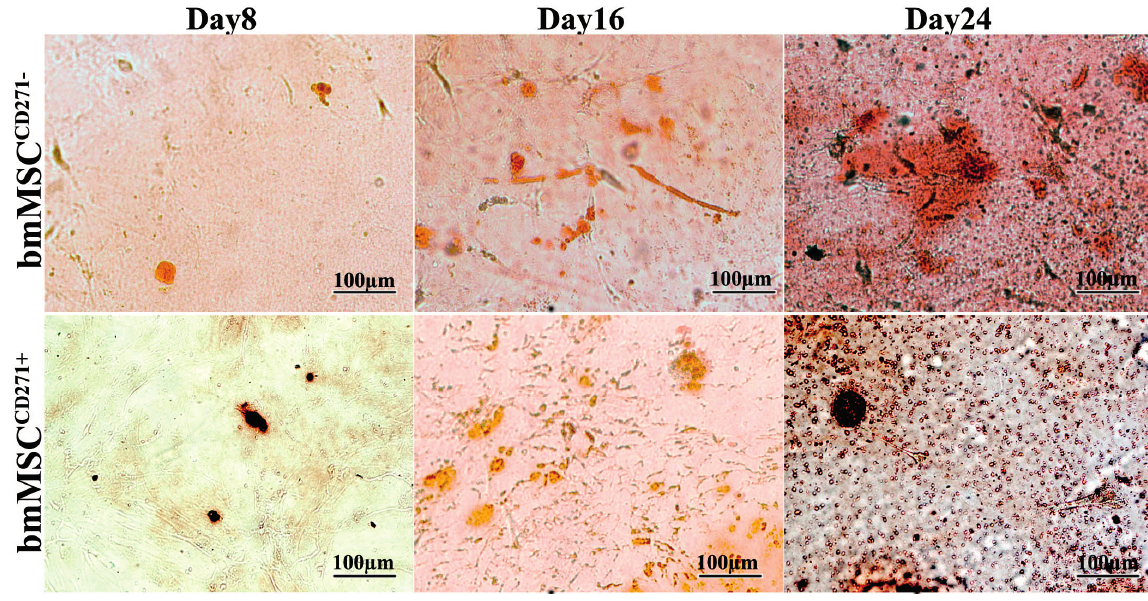
Figure 3. Oil-Red O staining of bmMSC CD271 − , bmMSC CD271+ and adMSC CD271+ after 7, 14 and 28 days of adipogenic